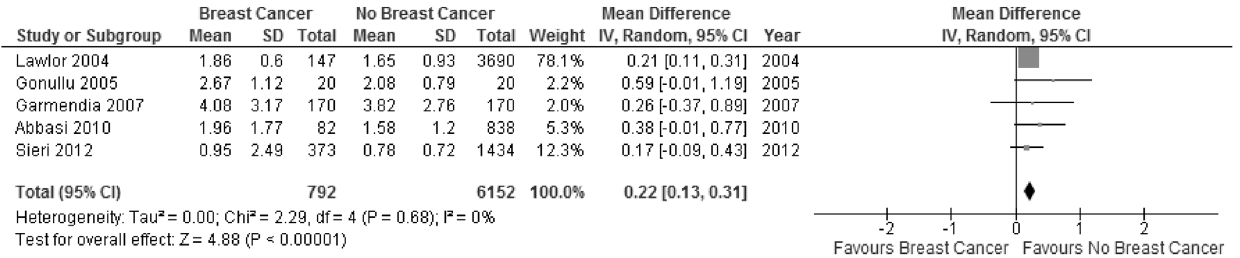
Figure 5. Forest plot of observational studies comparing women with and without breast cancer for HOMA-IR levels. (IV, Random = Inverse variance, Random effects model.)